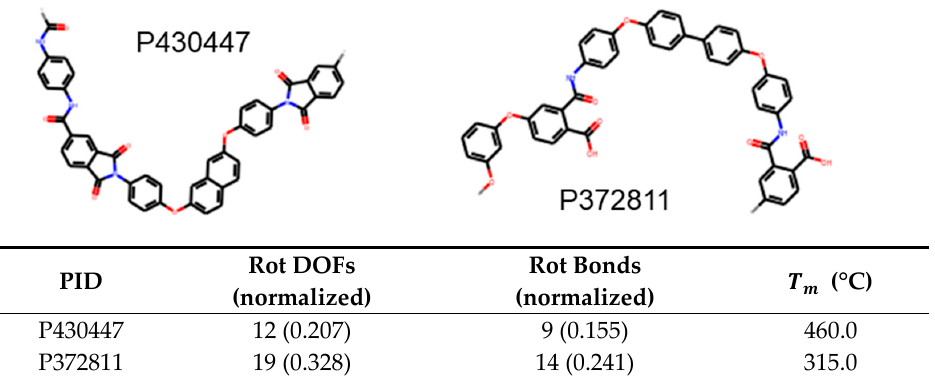
Figure 9. Example of two polyamides, with IDs P430447 and P3272811, whose melting temperatures can be predicted using trend in rotational DOFs .